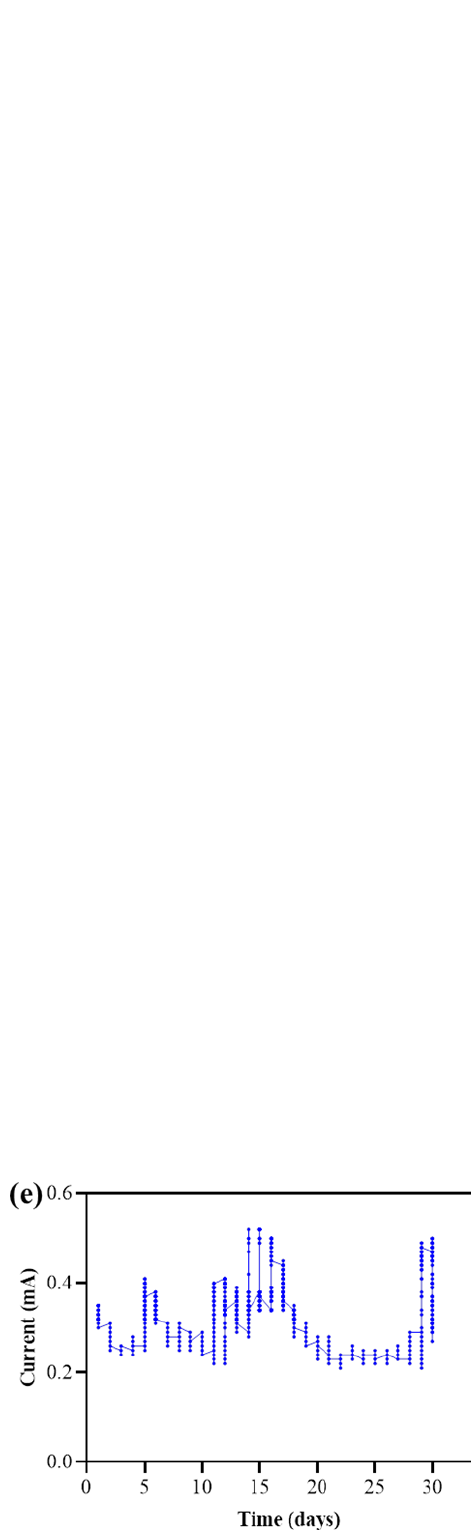
Figure 5. Current values obtained during the 30 days of the monitoring of reactors ( a ) P- MFC-2, ( b ) P-MFC-1*, ( c ) P-MFC-3, ( d ) P-MFC-4, and ( e ) Control.